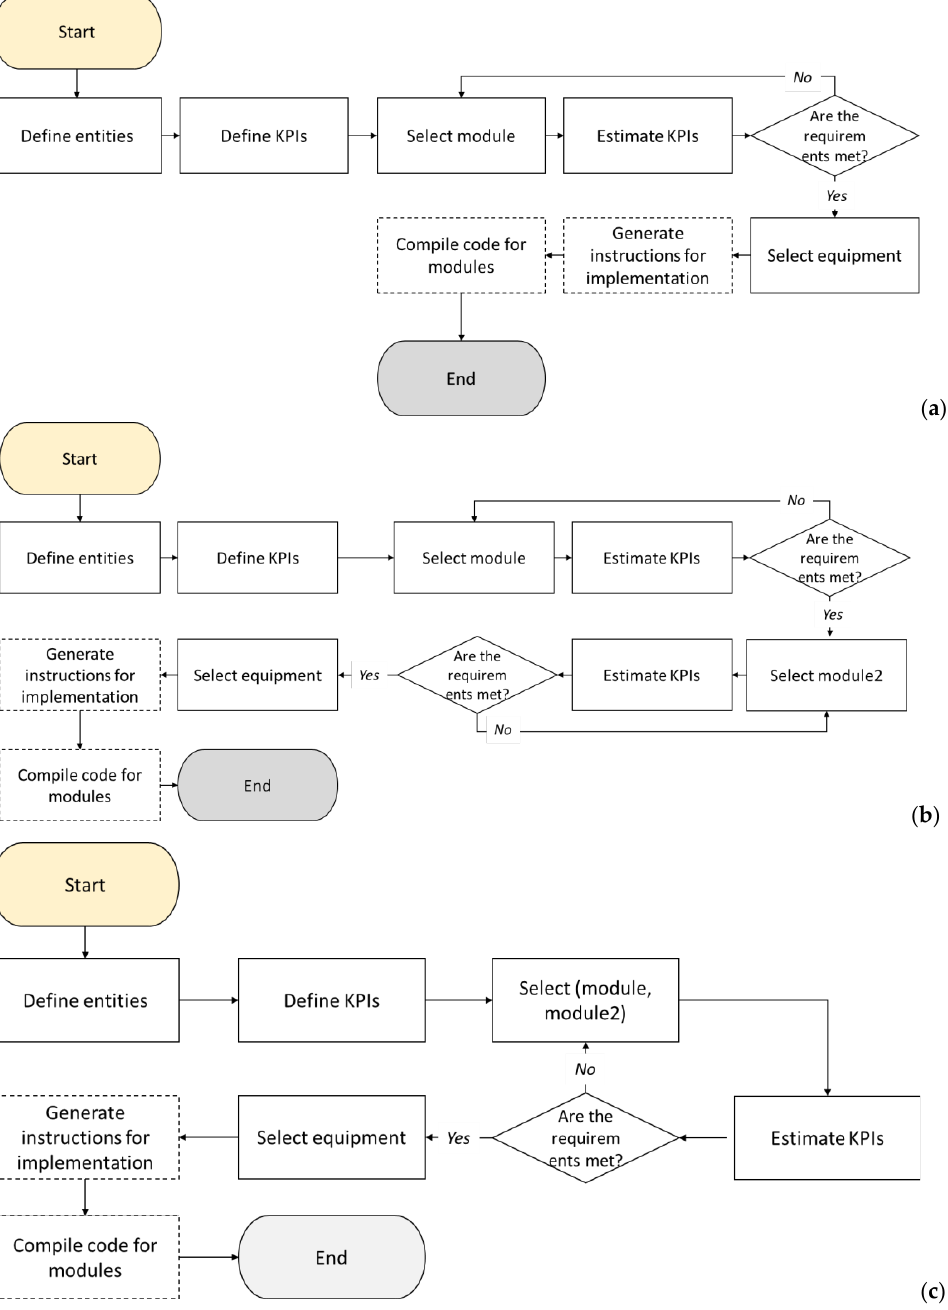
Figure 5. Three different workflows: ( a ) single optimization, ( b ) sequential double optimization, ( c ) concurrent double optimization.